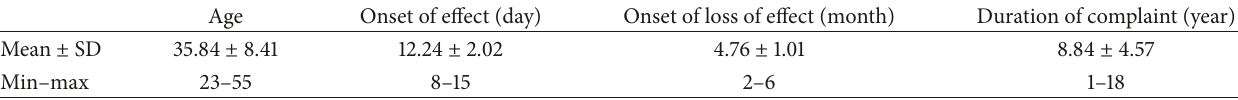
Table 3: The characteristics of the patients according to age, onset of effect, onset of loss of effect, and duration of complaint.